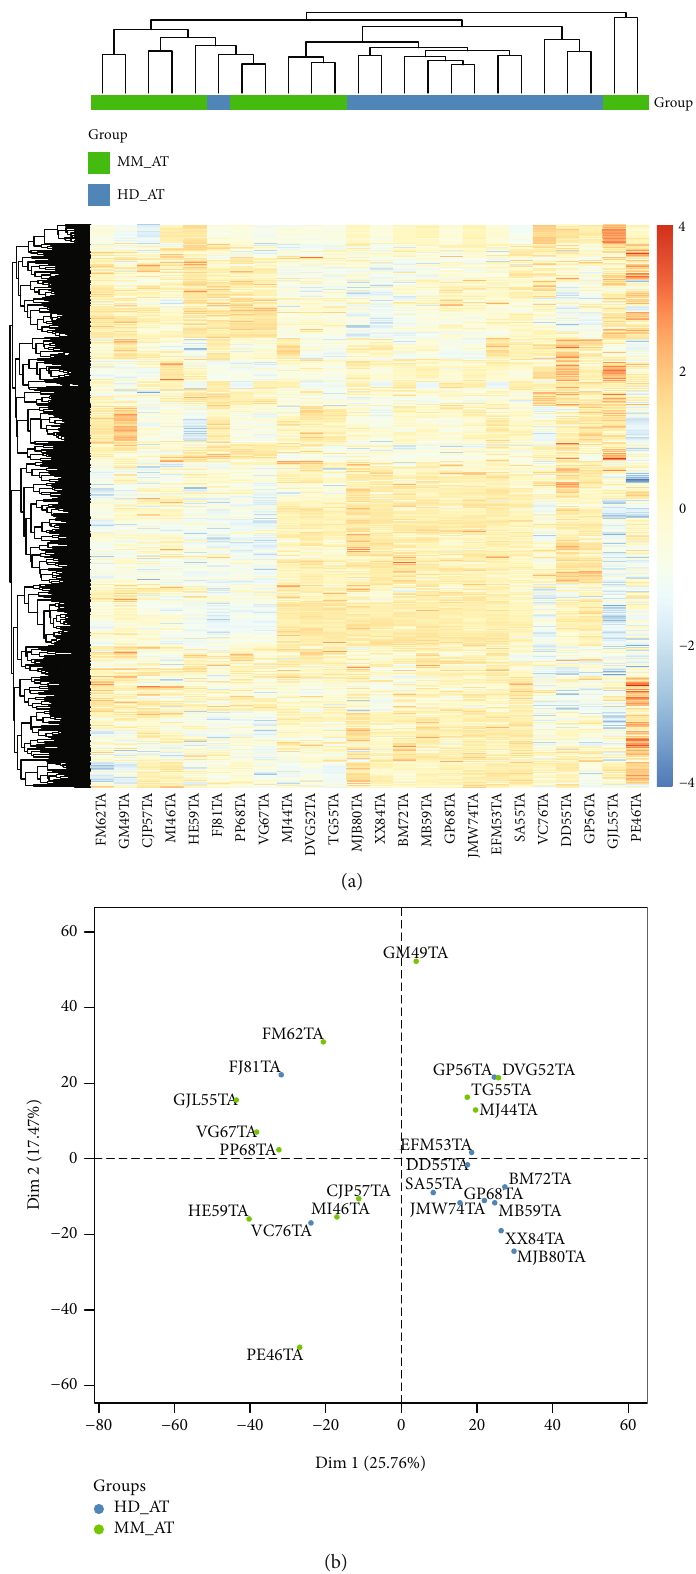
Figure 1: Transcriptomic comparison between multiple myeloma (MM) and healthy donor (HD) adipose stromal cells (ASCs). (a) Heatmap of di ff erentially expressed genes between HD ASCs (blue, n = 12 ) and MM ASCs (green, n = 12 ). (b) Principal component analysis of total gene expression from HD ASCs (blue, n = 12 ) and MM ASCs (green, n = 12 ). Each point corresponds to one